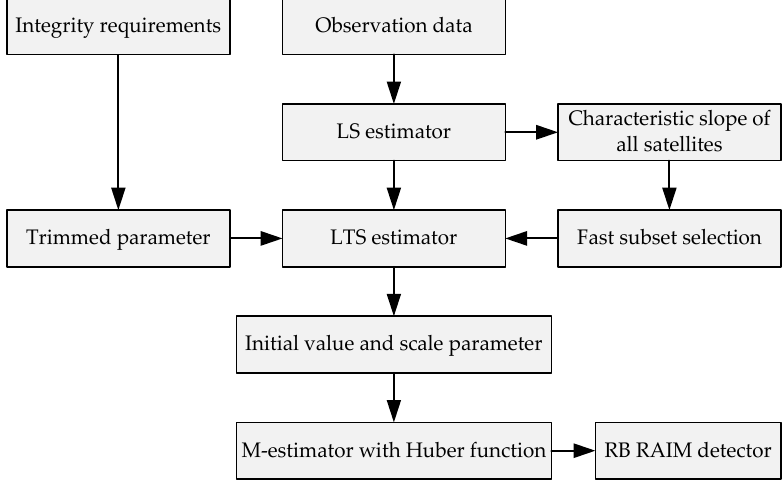
Figure 2. Flow chart of an RB detector based on an MM estimator.